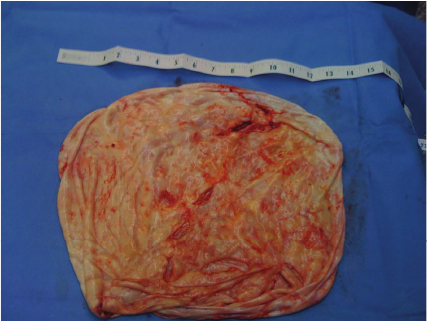
Figure 1: Huge ovarian serous cystadenoma specimen from patient